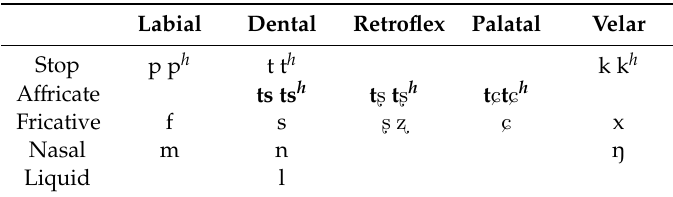
Table 1. Mandarin